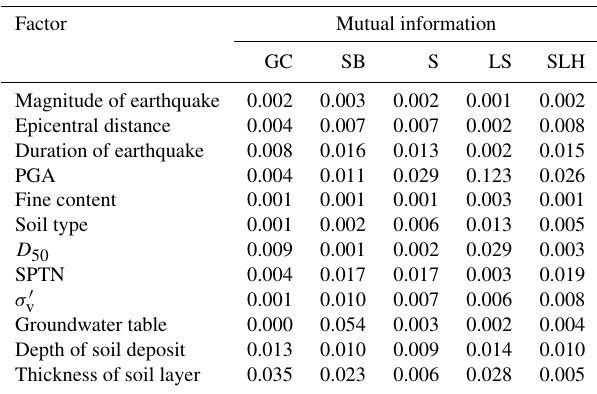
Table 8. Sensitivity analysis of seismic liquefaction-induced haz-